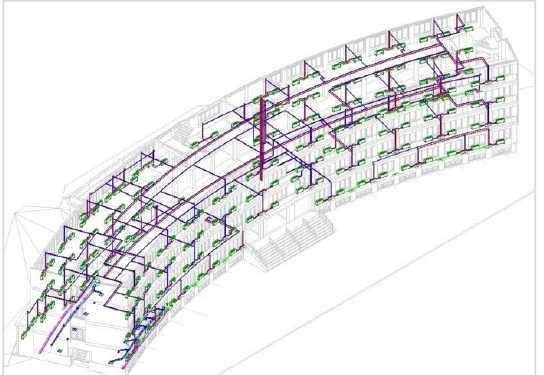
Figure 12: Axonometric sectioned view of fan-coil distribution between the ground floor and third